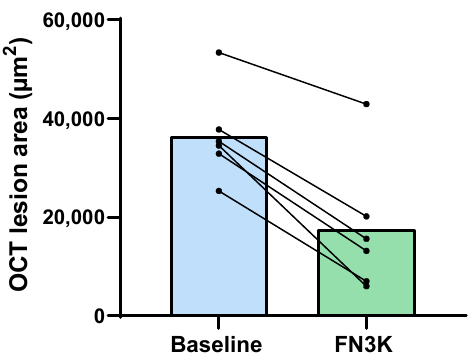
Figure 7. The area ( µ m 2 ) of drusenoid lesions ( n = 6) on optical coherence tomography (OCT) images in post-mortem human eyes from AMD patients ( n = 3) at baseline and 2 h after injection with a fructosamine-3-kinase (FN3K) solution. The bars represent the mean.